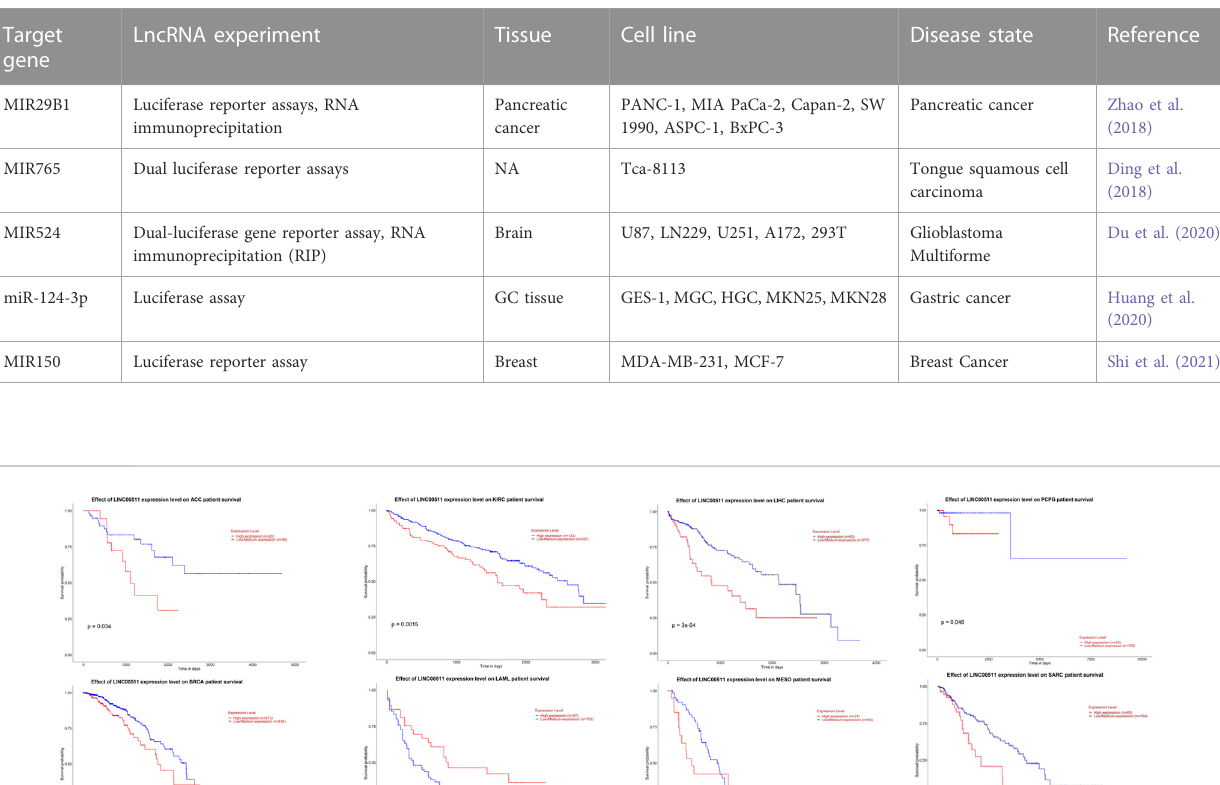
TABLE 5 LINC00511 interactions with miRNAs.